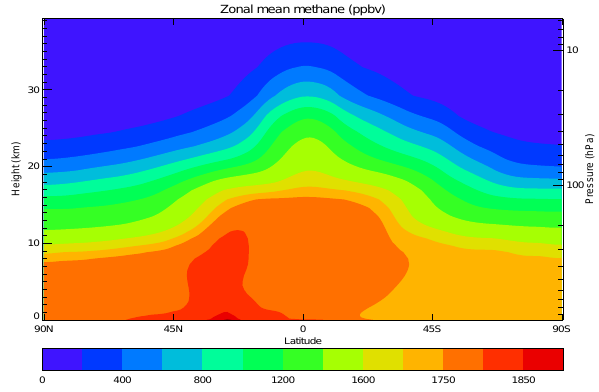
Fig. 2. Annually average zonal mean methane concentrations gen- erated by the HadGEM2 chemistry driven with 2005 emissions of methane and ozone precursors from Jones et al.